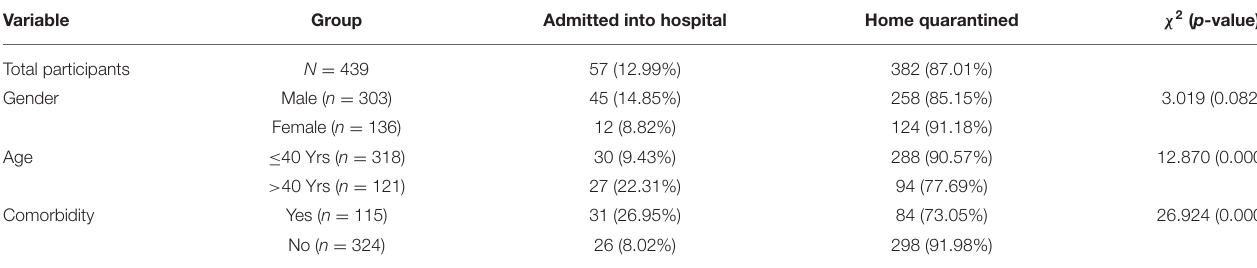
TABLE 2 | Hospitalization due to COVID-19 associated complications, Bangladesh, 2020.